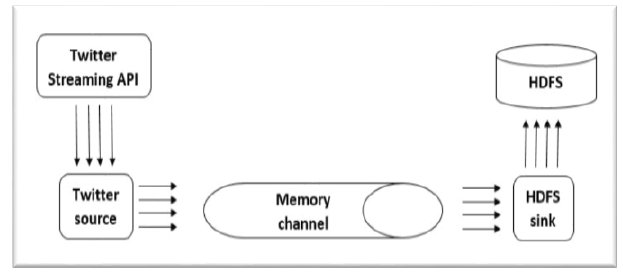
Figure 1. Flume Components